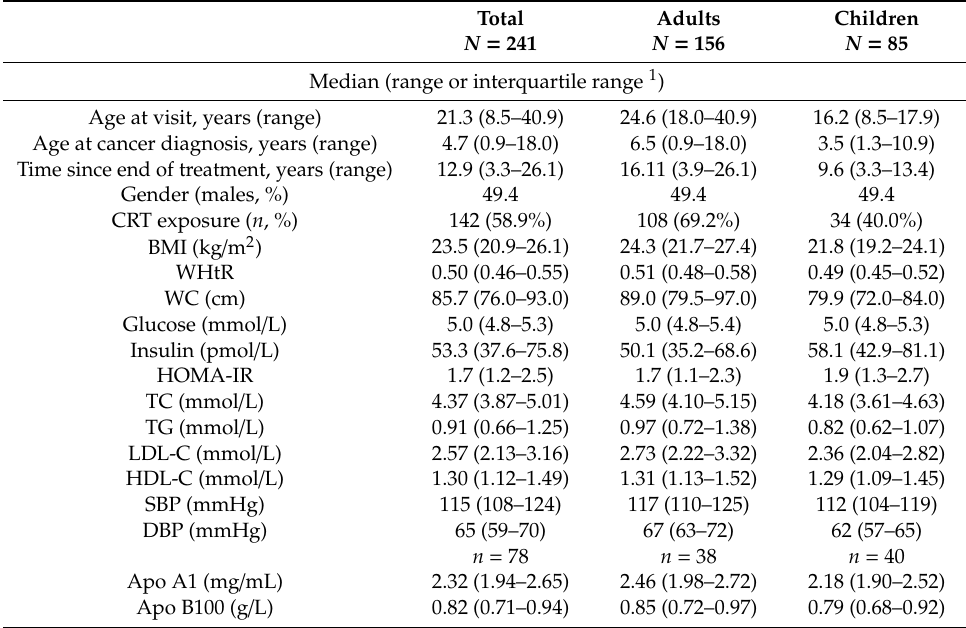
Table 1. Demographic and clinical characteristics of